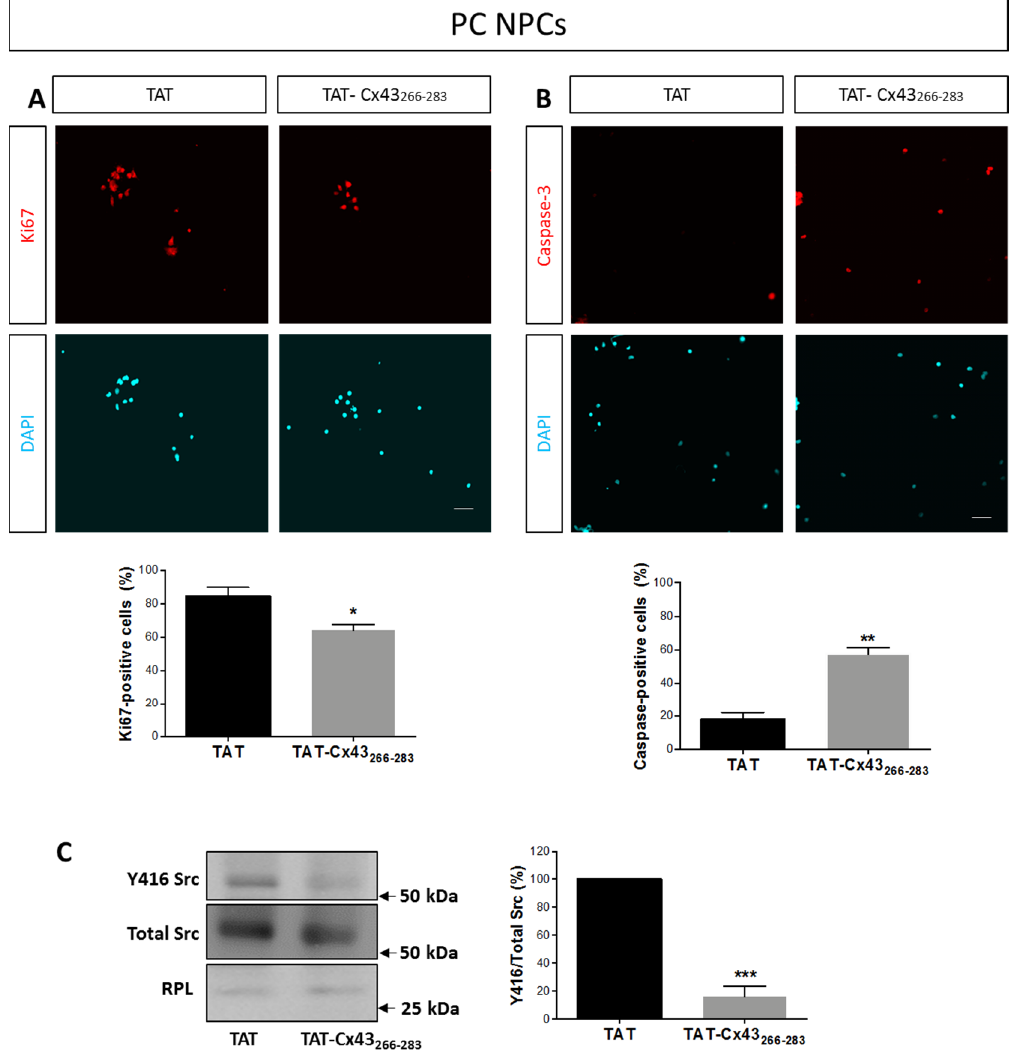
Figure 3. Effect of TAT-Cx43 266–283 on neural progenitor cell proliferation, apoptosis, and Src activity in proliferation conditions. ( A , B ) Representative epifluorescence images and quantifications of Ki67 ( A , in red) or caspase-3 ( B , in red) immunostaining in cultures of neural progenitor cells in proliferation conditions (PC NPCs) treated with 25 µ M TAT or TAT-Cx43 266–283 for 72 h. Cell nuclei of the same fields were visualized by DAPI staining (turquoise). Bar: 75 µ m. Results are expressed as percentage of Ki67-positive cells (in A ) or caspase-3-positive cells (in B ) and are the mean ± SEM ( n = 3; * p < 0.05; ** p < 0.01; Student’s t -test). ( C ) Western blotting showing Y416 Src and total Src in PC NPCs treated with 25 µ M TAT or TAT-Cx43 266–283 for 72 h. Quantification of Y416 Src / Src ratio expressed as a percentage with respect to TAT. Results are expressed as mean ± SEM ( n = 4; *** p < 0.001; Student’s t -test).